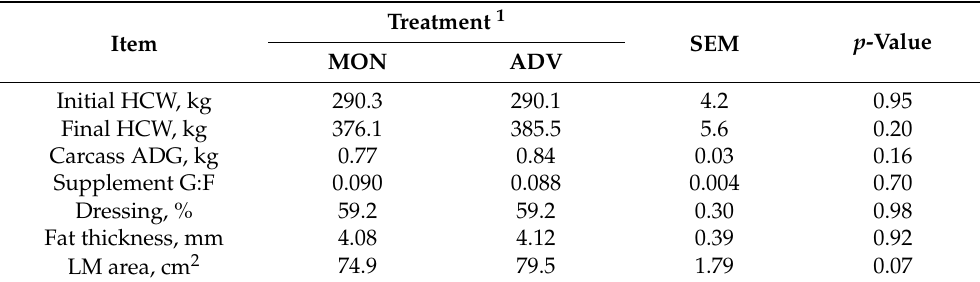
Table 5. Carcass measures of Nellore bulls finished on pasture with high concentrate supplementation, with monensin (MON) or a blend of live yeast and organic minerals (ADV). Item